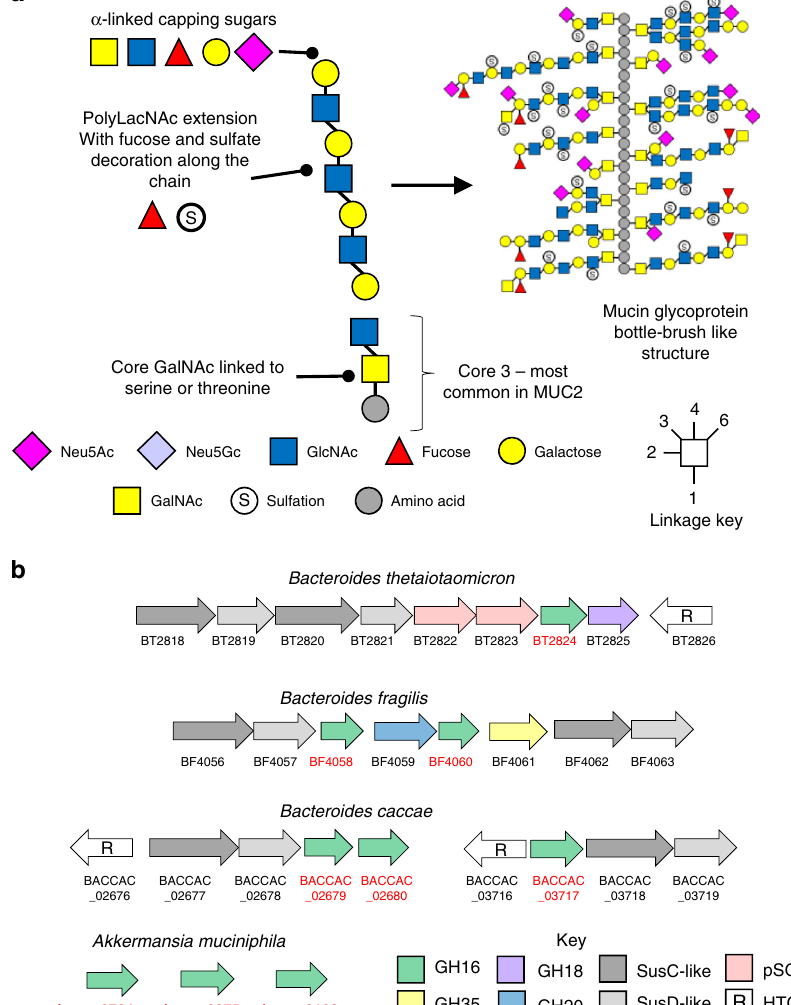
Fig. 1 Mucin structure and genomic context of the loci encoding the mucin-associated GH16 enzymes. a Left: the main structural features of a model mucin O-glycan chain. All mucin oligosaccharides are linked via an α -GalNAc to serine and threonine residues in the peptide backbone. A number of different core structures are then attached, with core 3 (shown) being the most common in the large intestinal MUC2. The cores are then often extended with polyLacNAc repeats of varying lengths which are decorated along their length by sulfation and fucosylation and capped at the non-reducing end by a variety of α -linked monosaccharides. Right: a model of an intestinal mucin glycoprotein showing complexity and variability of glycan chains attached to peptide backbone. b Genetic context of the GH16 encoding genes identi fi ed as being upregulated in the four species shown during growth on mucin (see Supplementary Figs. 1 – 3). In Bacteroides spp. the GH16 genes (highlighted red) are part of discrete polysaccharide utilisation loci (PULs), cluster of co- regulated genes encoding glycan degradation and uptake apparatus (SusC-like and SusD-like outer membrane proteins, additional CAZymes and putative surface glycan binding proteins (pSGBPs), often adjacent to a hybrid two component system (HTCS) sensor-regulators that likely control expression of the associated PUL. Glycan utilisation genes are not organised into PULs in the A. muciniphila